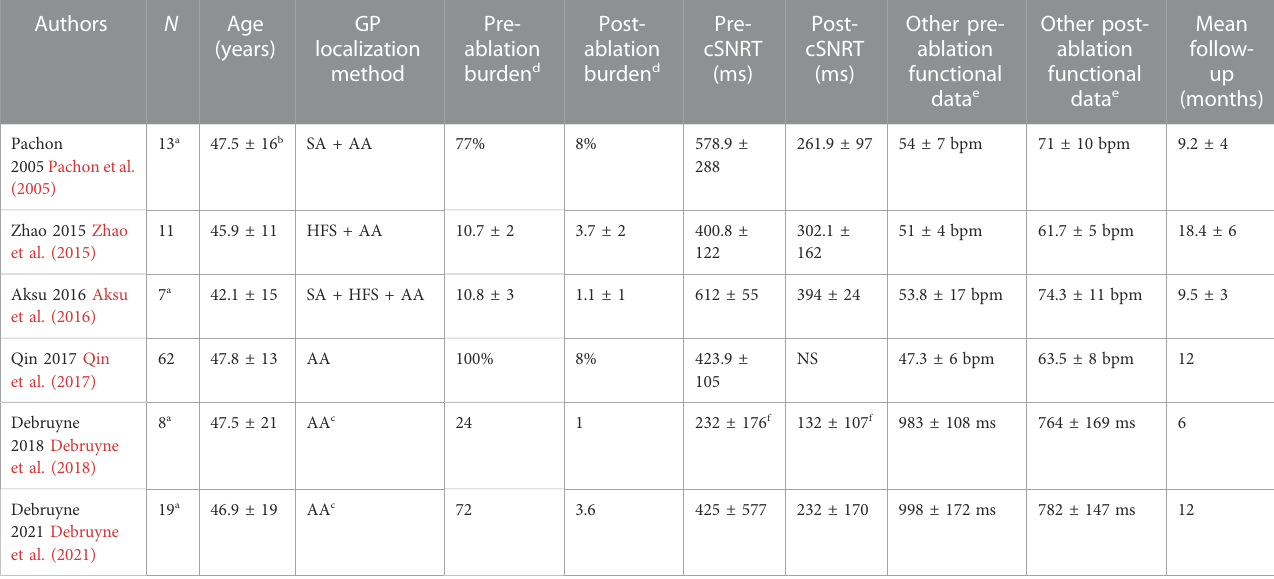
TABLE 1 Studies on cardioneuroablation for sinus node dysfunction.